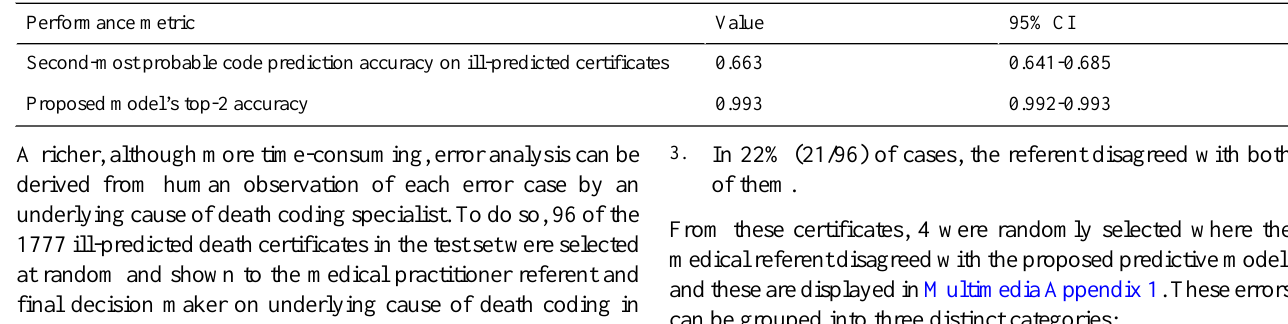
Table 2. Accuracies on codes wrongly predicted by the proposed model, and the model’s top-2